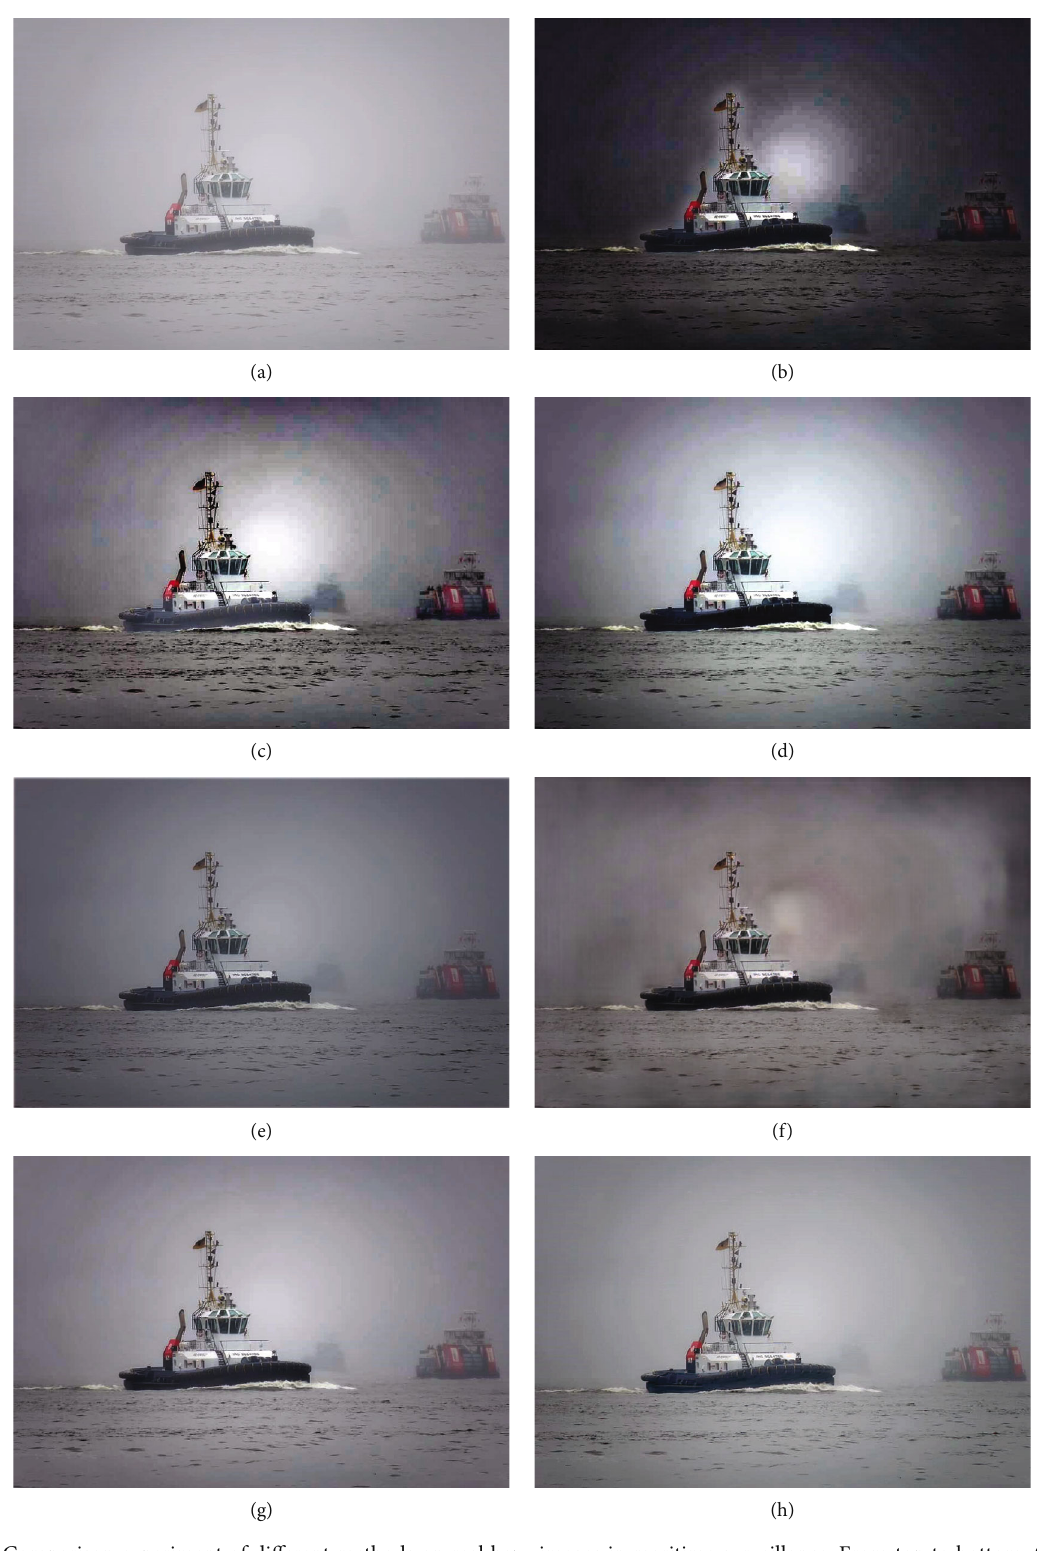
Figure 10: Comparison experiment of di ff erent methods on real hazy images in maritime surveillance. From top to bottom: (a) real hazy image and restored images, generated by (b) DCP [19], (c) nonlocal [37], (d) F-LDCP [20], (e) AODNet [25], (f) GCANet [26], (g) MSCNN [24], and (h) ours,